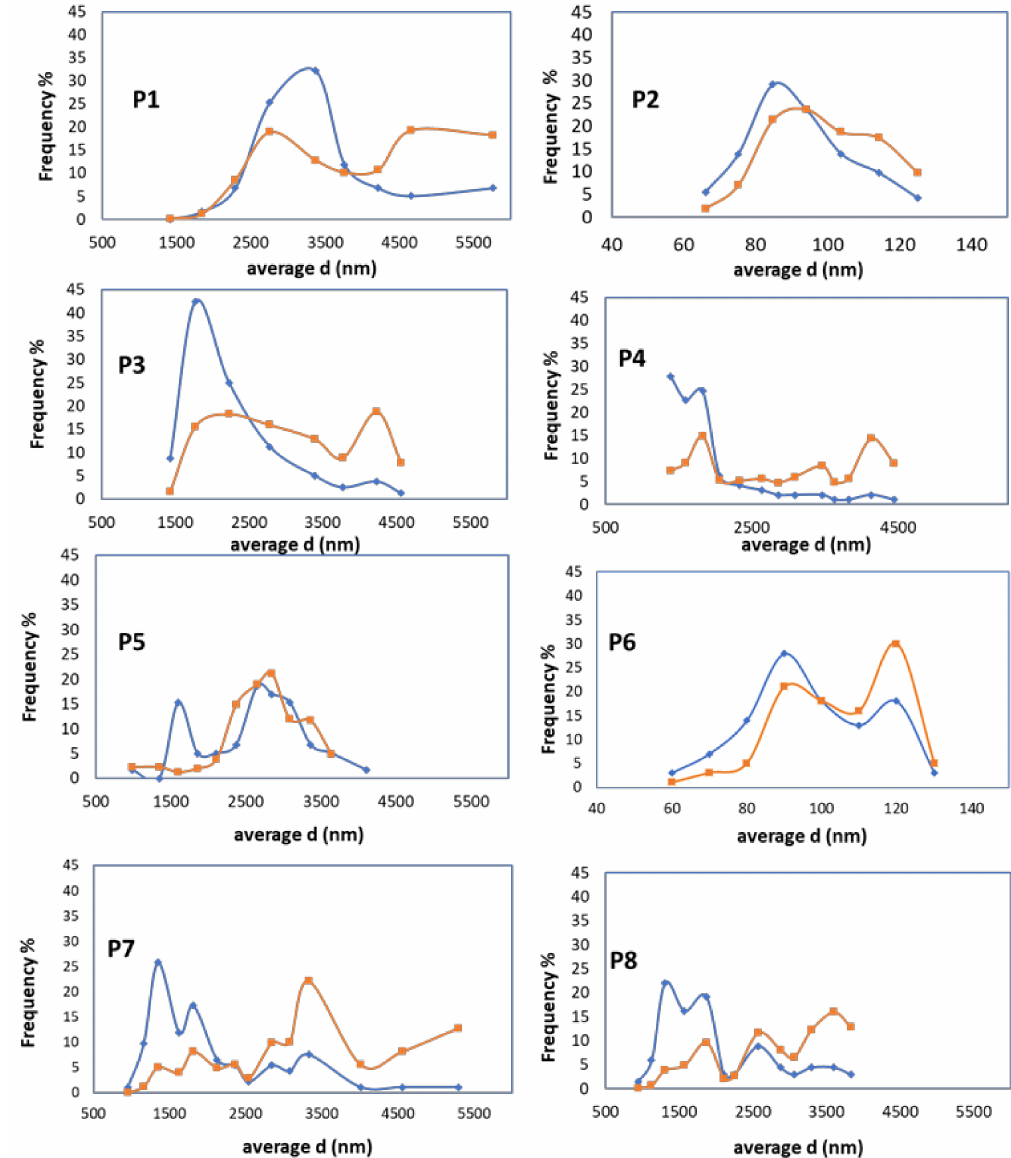
Figure 3. Calcium carbonate particle diameter (d) for samples P1–P8: number average (blue line) and weight average (orange line)